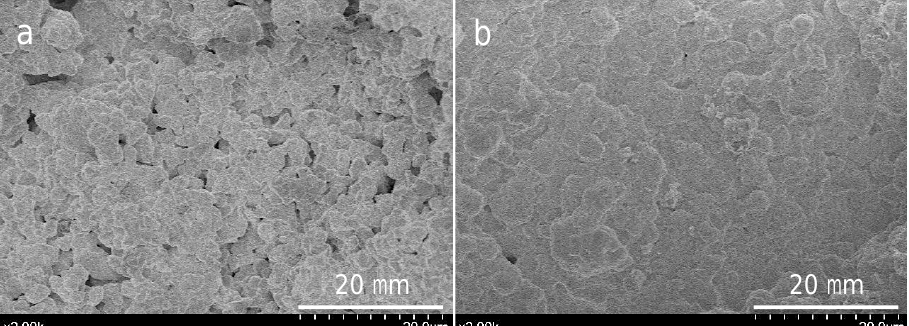
Figure 10. FEG-SEM observations on fracture surfaces of the hydrated ACaNO-HNO formulation: ( a ) without post-synthesis treatment; and ( b ) implementing EPT.